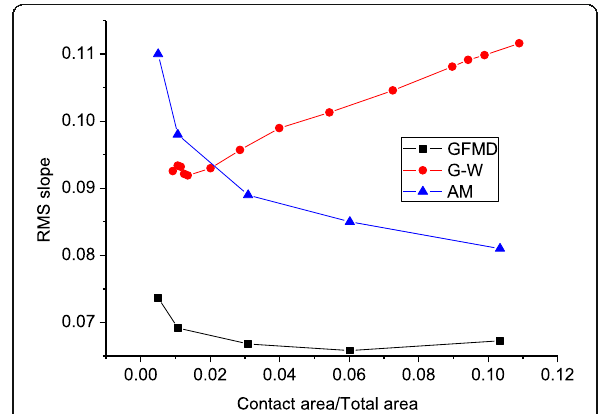
Fig. 10 The contact clusters ’ RMS slope with different contact areas for different models, where the surface RMS slope is 0.077